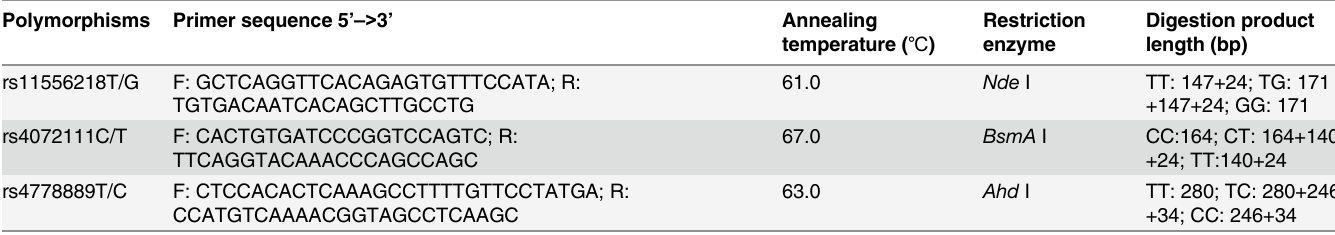
Table 1. Primer sequences and reaction conditions for genotyping IL-16 polymorphisms. Polymorphisms Primer sequence 5 ’– > 3